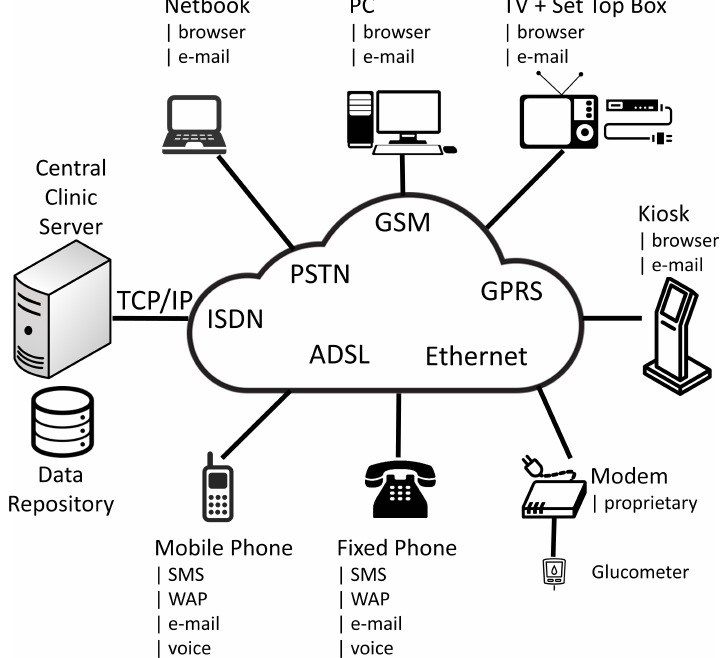
Figure 2. The web-centric architecture emerged during the first decade of the new century. A large number of devices accessed a central server using multimodal